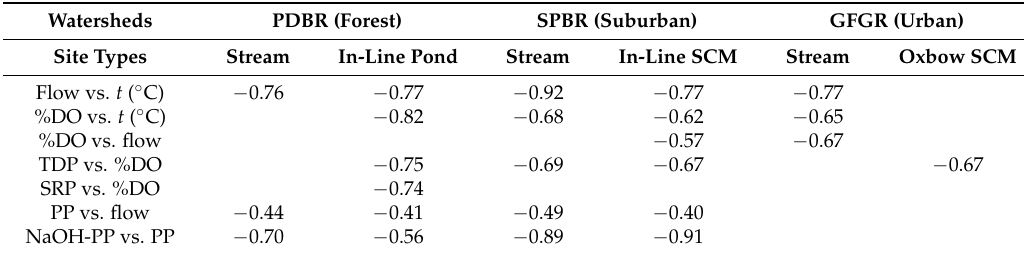
Table 3. Correlations between water quality parameters (dissolved oxygen (%DO), water temperature ( t ) or flow) and concentrations of P forms in the stream or pond/SCMs within an ecosystem type. Watersheds